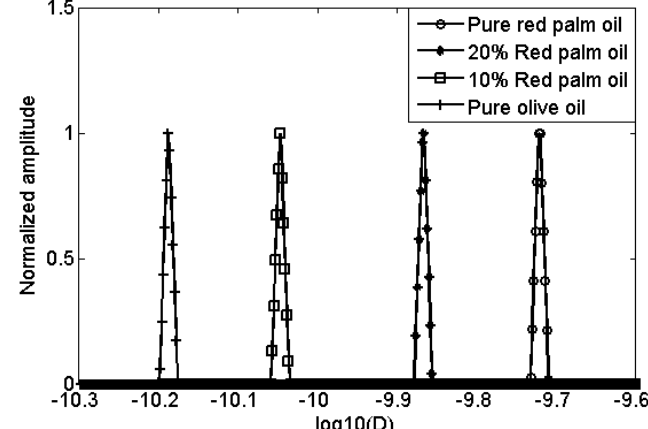
Figure 6. 1d diffusion coefficient distribution of red palm and extra virgin olive mixed oils.